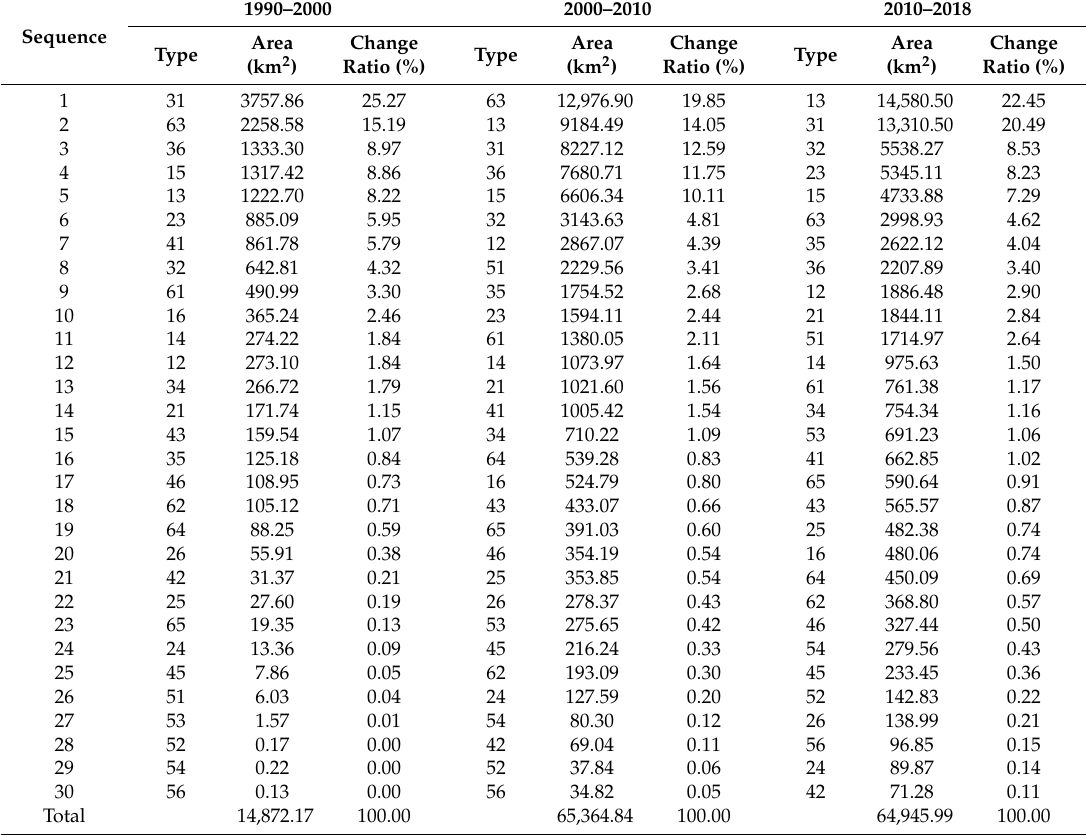
Table 3. Tupu unit sequence of land use transitions (LUTs) from 1990 to 2018 in the YRB.